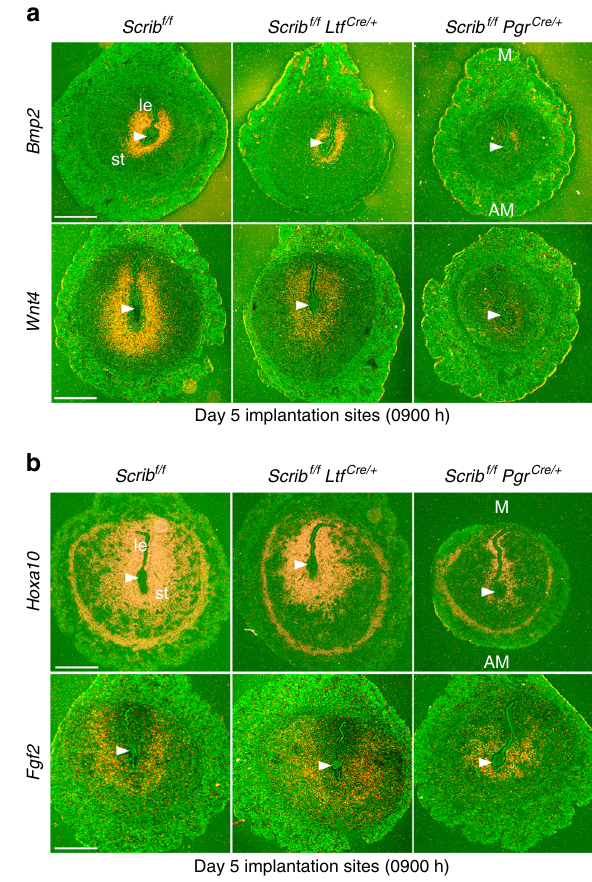
Fig. 3 Stromal cell Scrib deletion compromises initiation of decidualization. a , b In situ hybridization of Bmp2, Wnt4, Hoxa10 , and Fgf2 in each genotype on day 5 implantation sites show robust disrupted pattern in Scrib f/f Pgr cre/ + mice. Scale bar, 500 μ m. Arrowheads indicate the location of blastocysts. Each image is a representative of at least three independent